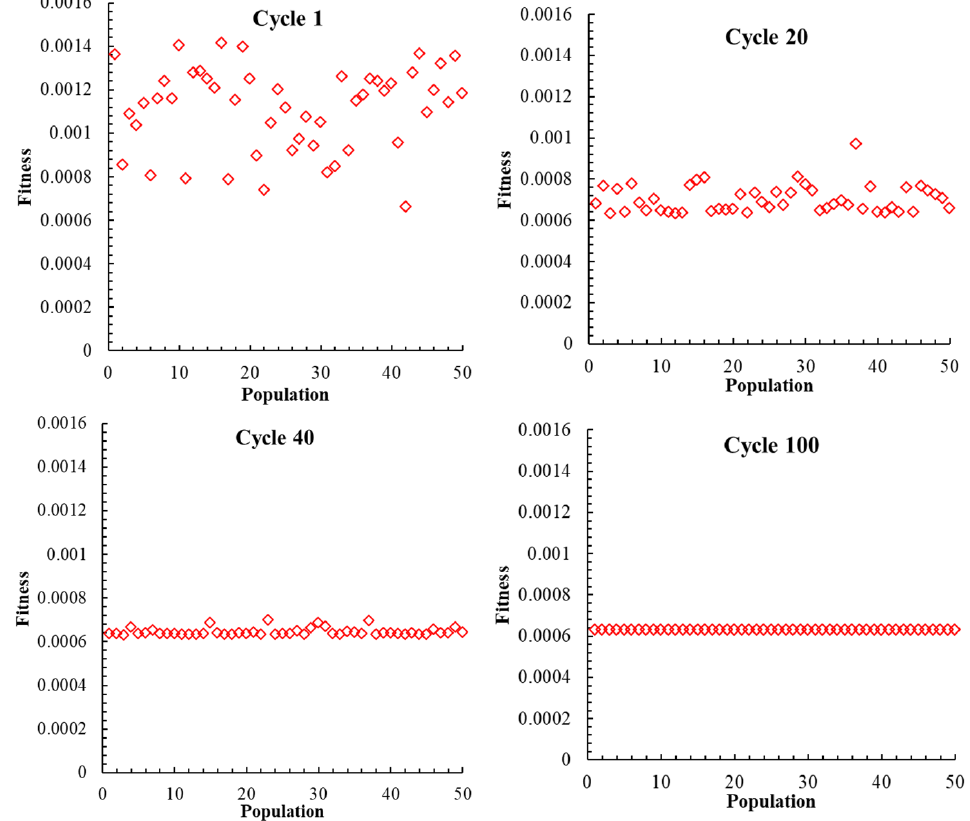
Figure 18. The varied process of fitness with the cycle.